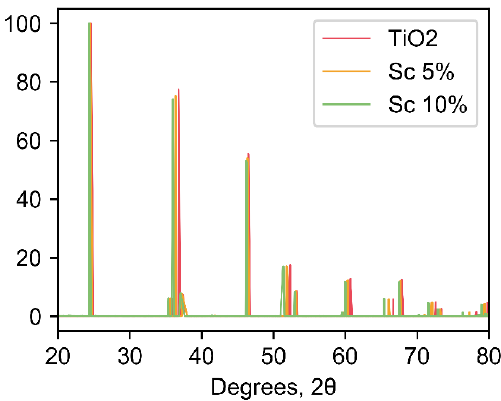
Figure A3. Powder diffraction pattern of pure and Sc-doped anatase simulated by VESTA code. The wavelength of the source was 1.54187 Å.